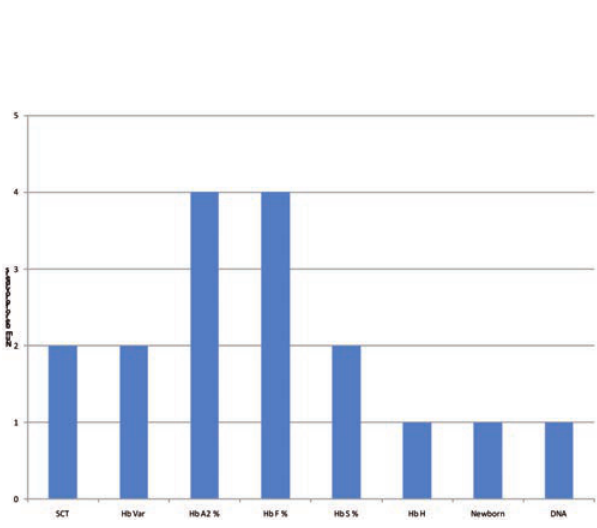
Figure 1. EQA provision for tests from the General section of the core list of laboratory tests.